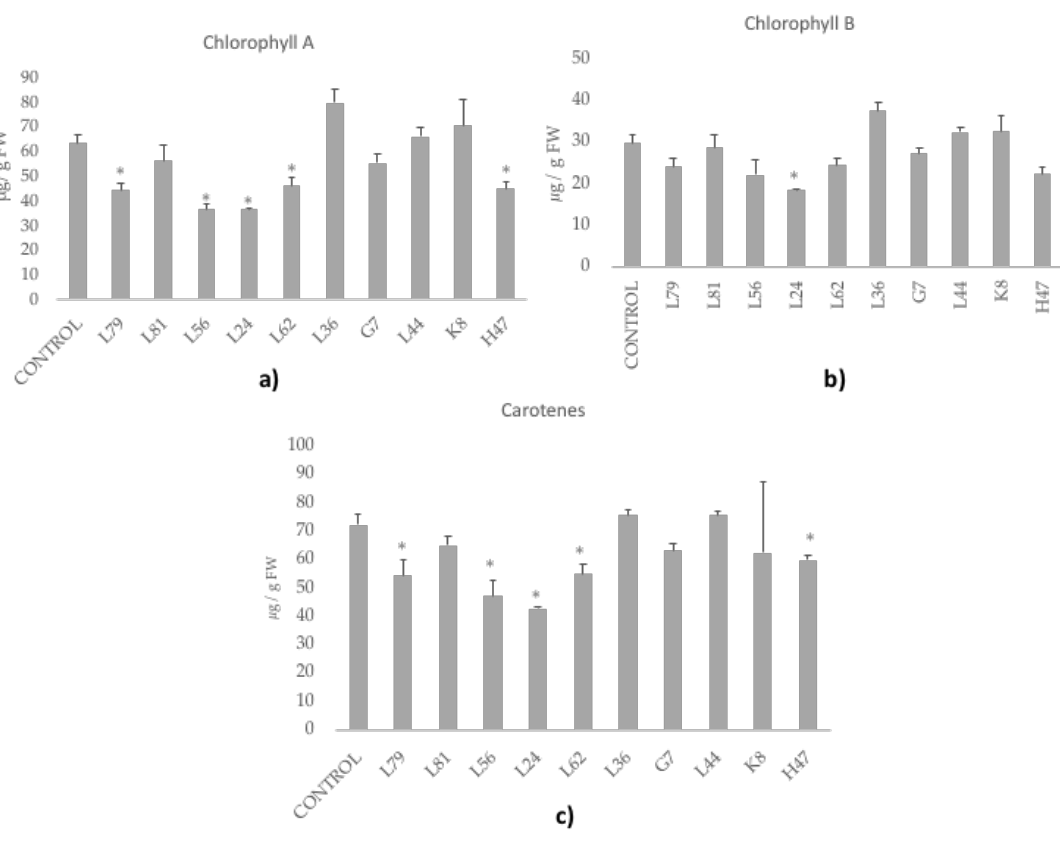
Figure 3. Photosynthetic parameters related to C fixation measured in olive tree plants treated with the ten strains. ( a ) Net photosynthesis (PN) measured as the CO 2 fixed by the leaves ( µ mol CO 2 / m 2 s). ( b ) Water Use E ffi ciency (WUE) calculated as PN divided by transpiration rate ( µ molH 2 O / m 2 s). Average values of the replicates with standard error bars are represented ( n = 6). Asterisks (*) represent significant di ff erences with the control according to the LSD test ( p < 0.05).